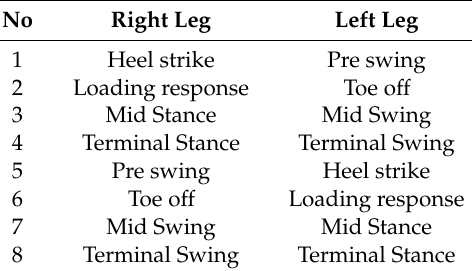
Figure 1. Human walking gait cycle (adapted from [11]). Table 2. Gait cycle position.